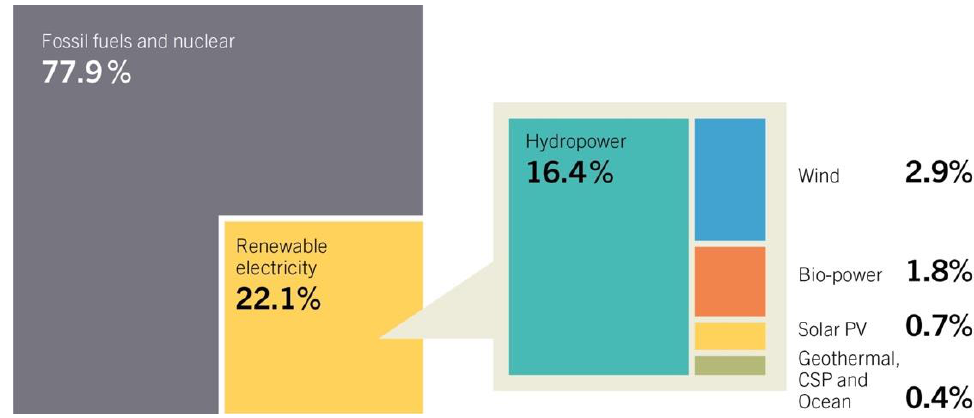
Figure 5. The industrial base of renewable energy is characterized as low compared to fossil fuels. (*CSP, Concentrated Solar Power) [19]. Energies 2016 , 9 , 676